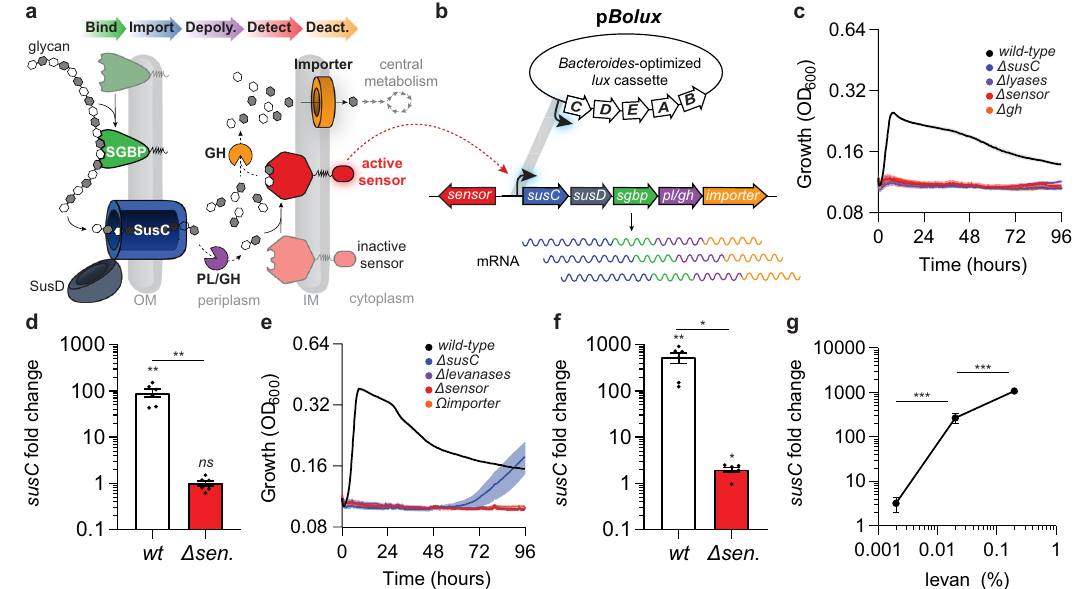
Fig. 1 | Bt PUL transcription re fl ects target glycan abundance. a A cartoon depicting prototypical glycan utilization by PUL-encoded gene products. SGBPs (green) speci fi cally bind target glycans in the extracellular milieu, which are transported across the outer membrane (OM) by the SusCD complex (blue). Internalized glycans are depolymerized by glycosyl hydrolase (GH) and poly- saccharidelyase(PL)activities(purple)generatingligandsthatconvertPULsensors (red) to their active form. PUL sensors are deactivated following removal of their ligands from the periplasm by GH activities or importation across the inner membrane (IM; orange). b Ligand-bound sensors direct increased PUL transcrip- tion by sequence-speci fi c interactions with PUL promoters. These promoters can beintroducedintop Bolux todriveglycan-responsivebioluminescence. c Growthof wild-type Bt (black) or strains lacking the CS-inducible susC ( Δ BT3332 , blue), 3 CS- speci fi clyases( Δ BT3324 Δ BT3350 Ω BT4410 ,purple),CS-sensor( Δ BT3334 ,red),ora glucuronyl hydrolase ( Δ BT3348 , orange) were measured during anaerobic culture increaseoftheCS-inducible susC ( BT3332 ) mRNAlevelsweremeasured byqPCR in either wild-type Bt (open bar) or a strain lacking the CS-sensor (red bar) following introduction of 0.2% CSintotheculturemedia.The fold increase wascalculated as thechangeintranscriptlevelsfromculturesbeforeand2haftertheintroductionof